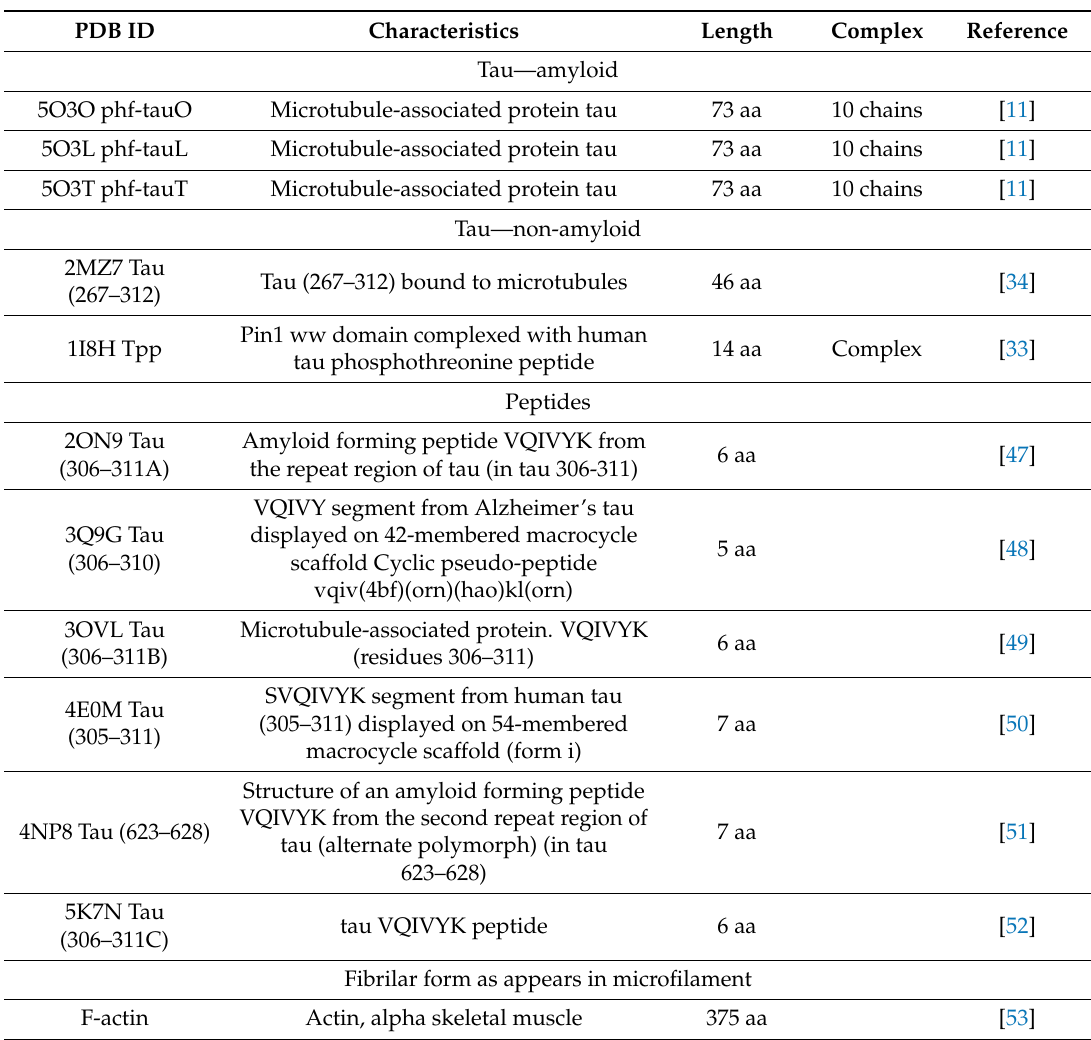
Table 9. Set of proteins subjected to analysis, along with an indication of chain length and complexation capabilities. The rightmost column provides